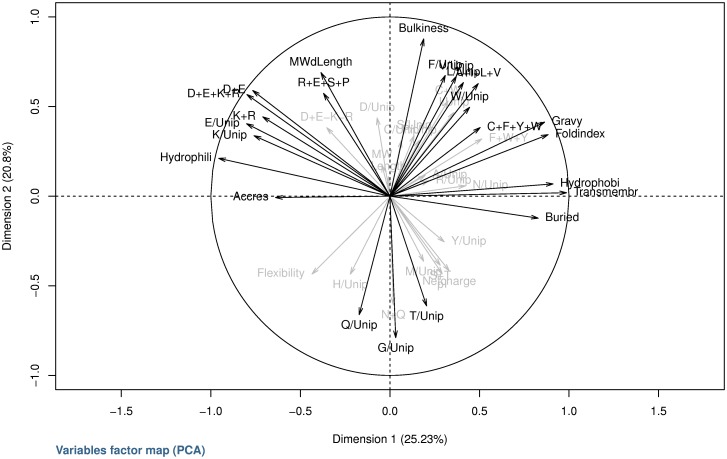
The main projection of the variables on the first two axis of the PCA.This is the correlation circle of the projection of the 45 variables using the first two components of the PCA. Axis I is horizontal and axis II is vertical. The most- contributing variables are in black, the others in grey.